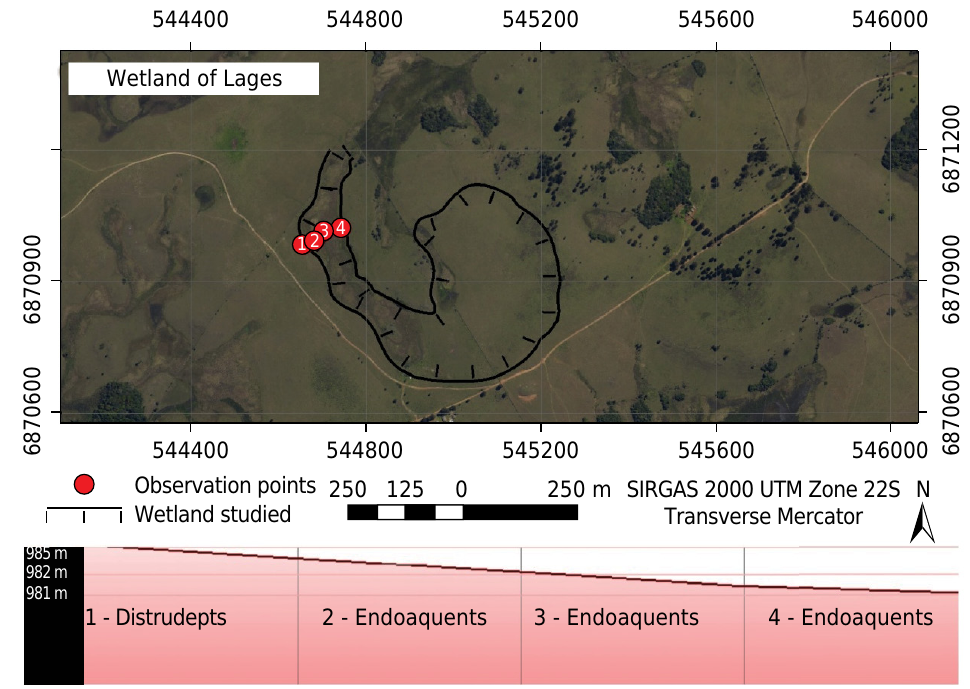
Figure 4. Location of the wetland in the municipality of Lages (LGS), SC, and elevation profile. Distance between points 1 and 2: 7 m; 2 and 3: 25 m; 3 and 4: 25 m. Figure of the Aerophotogrammetric Survey of the State of Santa Catarina, Brazil,